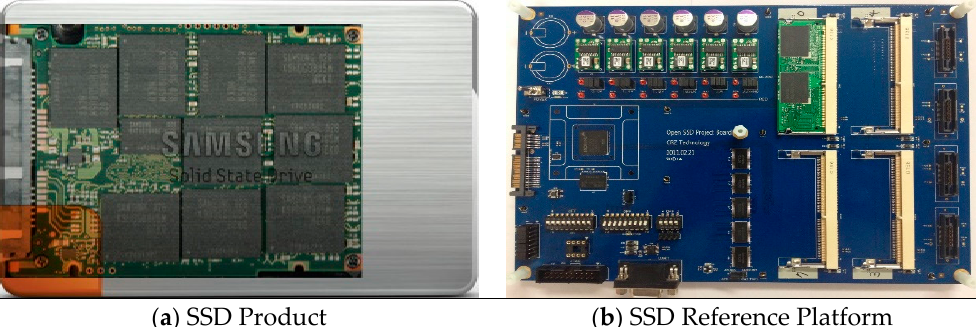
Figure 12. Flash storage devices.